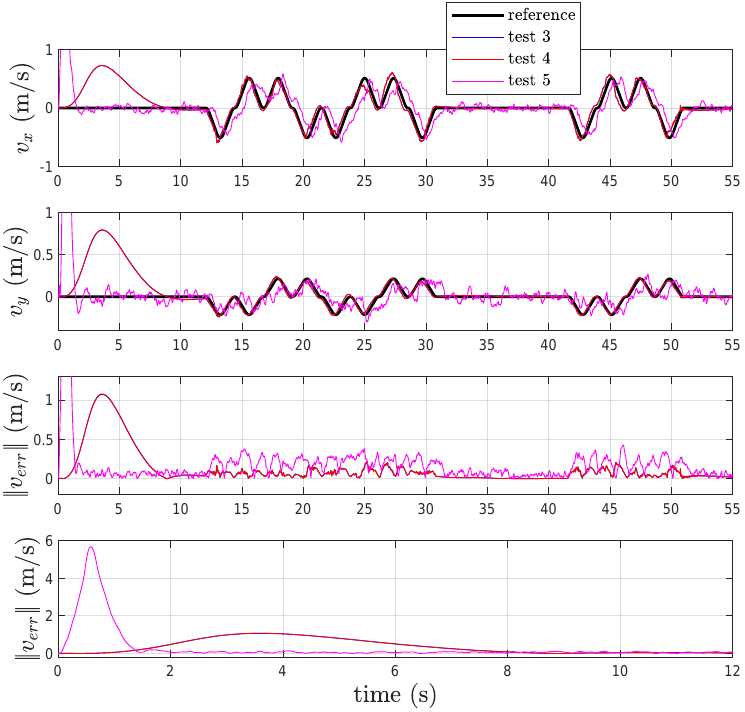
Figure 10. References, estimated velocities ˆ v , and corresponding norm-2 error (cid:107) v err (cid:107) in Test 3, 4 and Test 5